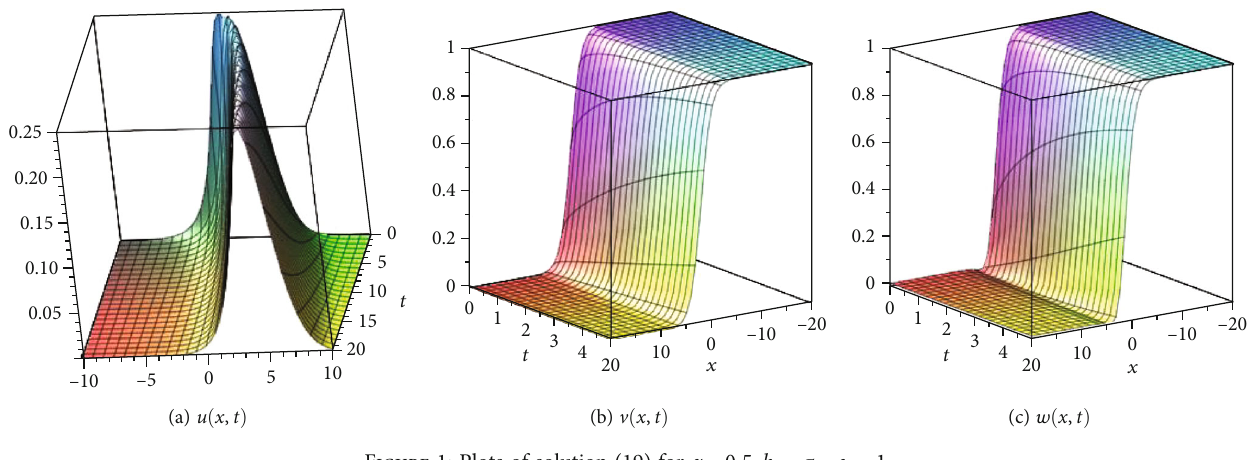
Figure 1: Plots of solution (19) for α = 0 : 5, b